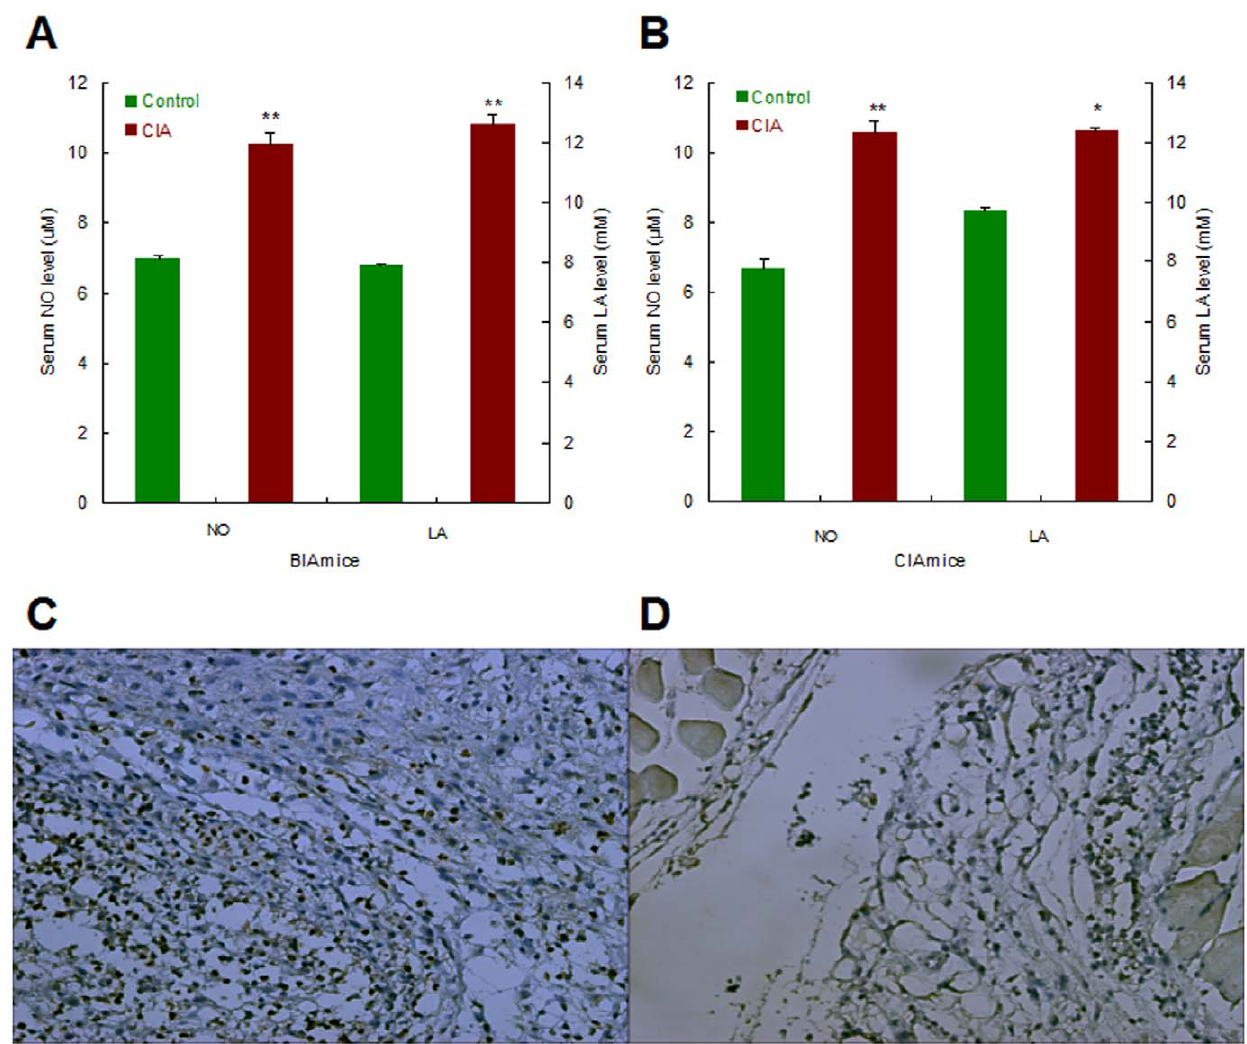
Figure 5. NO-driven hypoxia and angiogenesis in BIA and CIA mice. A. Serum NO and LA levels in BIA mice ( n =3); B. Serum NO and LA levels in CIA mice ( n =3); C. Immunohistochemical staining against HIF-1 a in the articular synovium of CIA mice ( 6 200); D. Immunohistochemical staining against VEGF in the articular synovium of CIA mice ( 6 200). Sampling and detection were conducted after modeling for 3 d in CIA mice. The singular asterisk (*) represents statistically significant difference from the control ( P , 0.05); and double asterisks (**) indicate statistically very significant difference from the control ( P , 0.01).